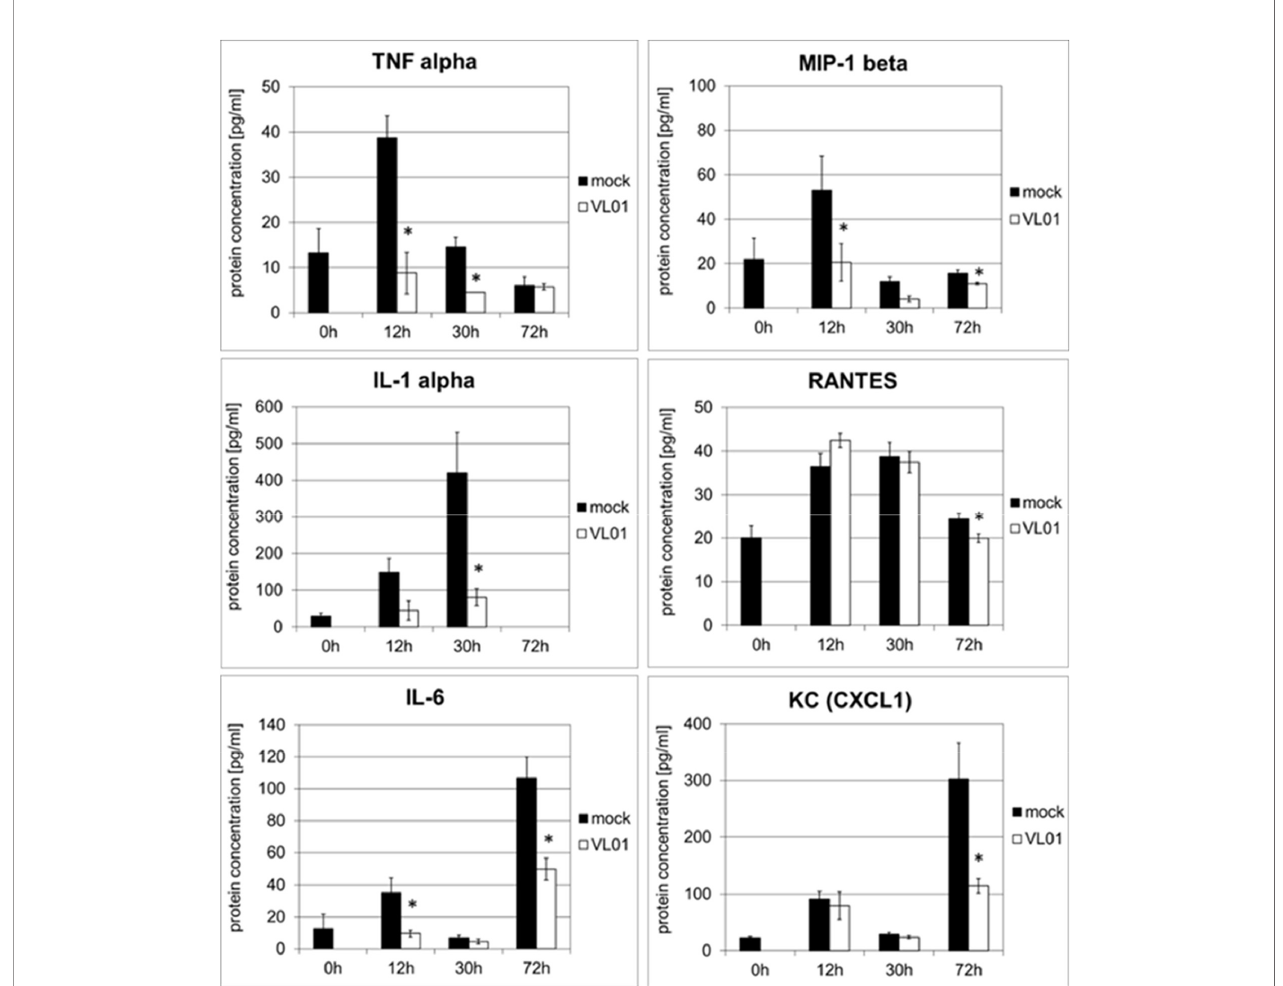
FIGURE 3 | Inhibition of cytokine release in BALB/c mice infected with H5N1 by treatment with the proteasome inhibitor VL-01. Balb/c mice (n = 4) were intranasal infected with avian H5N1 virus A/mallard/Bavaria/1/2006 (7 × 10 2 pfu, i.e. 10-fold MLD50). Mice were i.v. treated with 25 mg/kg VL-01 or solvent (mock) 2 h prior to virus infection. Cytokine levels in blood were determined before (0 h) and 12, 30, or 72 h after infection using the Bio-Plex Pro Mouse Cytokine 6-Plex Panel (Biorad). *p <